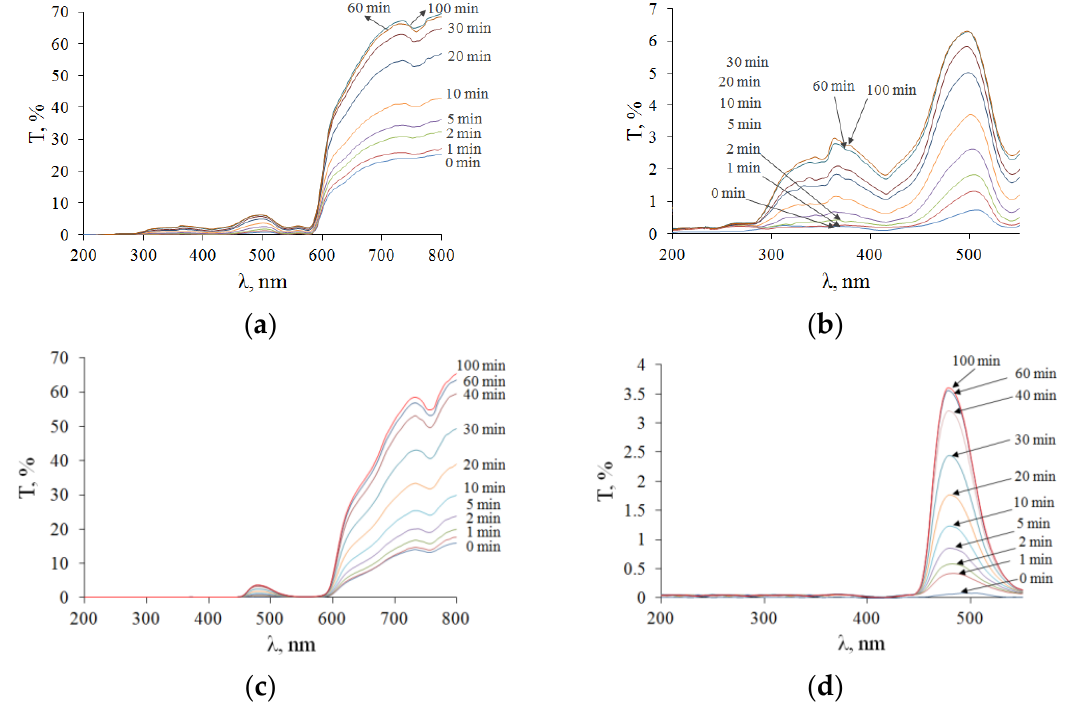
Figure 10. TTSs of cat ovarian tissue samples during 99.5% glycerol immersion: ( a , b ) F-ph; ( c , d ) L-ph.